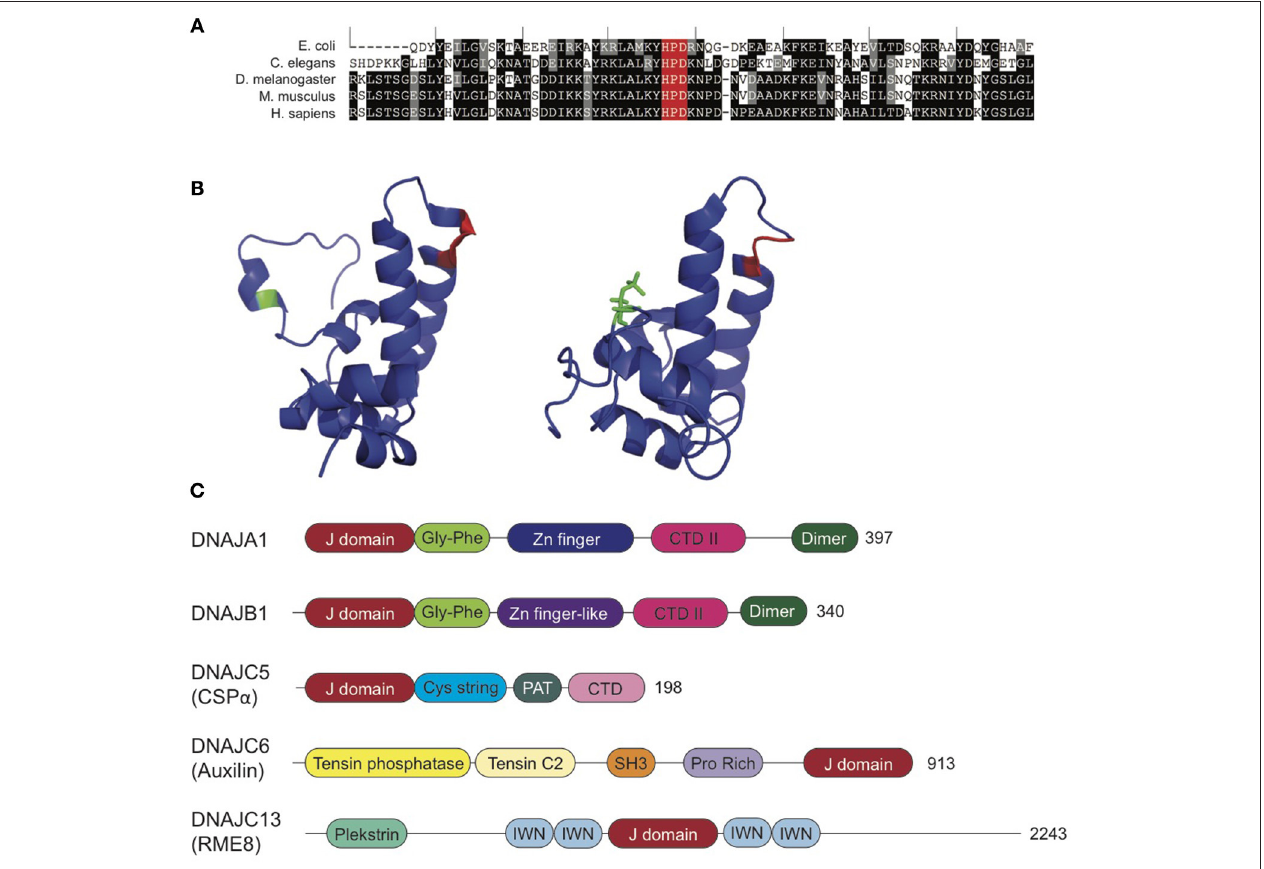
FIGURE 2 | Synaptic Co-Chaperones. (A) DNAJ proteins exhibit high homology within the J domain. J domains from E. coli DNAJ, C. elegans DNAJ14 and D. melanogaster , M. musculus , and H. sapiens DNAJC5. Black indicates identical residue. Gray indicates amino acids with conserved properties. The conserved HPD motif is highlighted in red. Sequence alignments generated using T Coffee (Notredame et al., 2000; Di Tommaso et al., 2011). (B) CSP α J domain exhibits conformational shift with phosphorylation at serine 10 (green). Unphosphorylated (left, PDB: 2N05) and phosphorylated (right; PDB: 2N04) CSP α J domain. HPD motif is highlighted in red. See, Patel et al. (2016) for further details. (C) Domain organization of J co-chaperones reviewed in this article: DNAJA1 (PDB: 2M6Y), DNAJB1 (Kampinga and Craig, 2010), DNAJC5 (CSP α ; PDB: 2N04 and 2NO5), DNAJC6 (auxilin; PDB: 3N0A), and DNAJC13 (Zhang et al., 2001). Not to scale. See also, Kampinga and Craig (2010). CTD, C-terminal domain; IWN, 90-amino acid conserved motif; PAT, palmitoylacyltransferase recognition